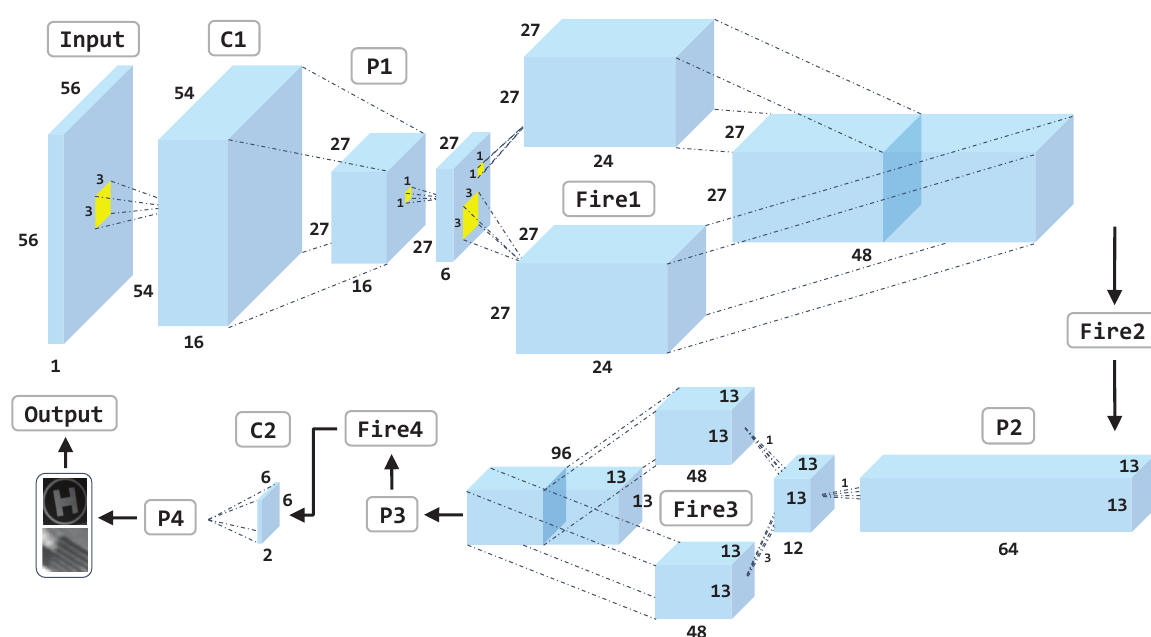
Figure 6. The proposed lightweight CNN architecture for marker